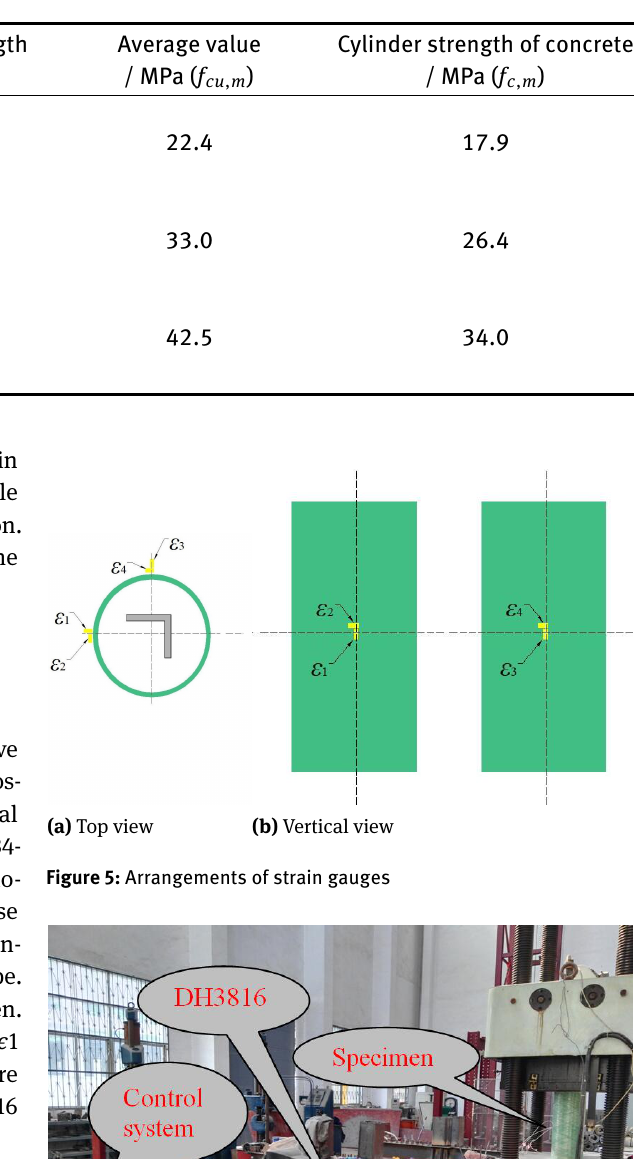
fiber in the GFRP tube functioned gradually and made a slight sound. When the load achieved about sixty percent of the ultimate load, the surface of GFRP tube started to appear some striae albicantes. What’s more, the color of fibrous coat changed from ondine to uneven local